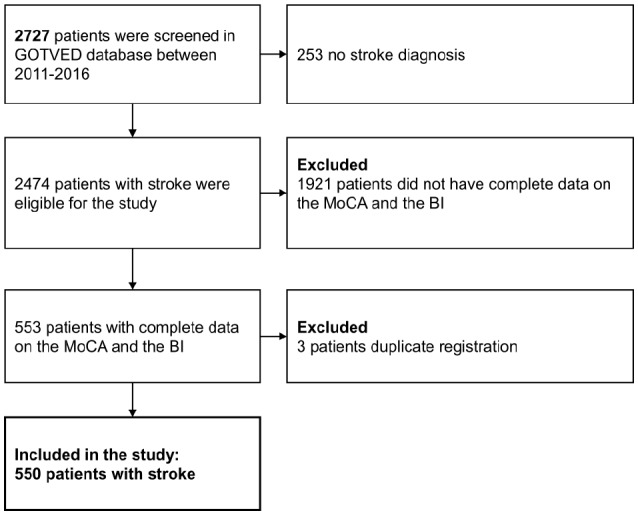
Flowchart of the participants. GOTVED, the Gothenburg Very Early Supported Discharge Study, MoCA, the Montreal Cognitive Assessment; BI, the Barthel Index.